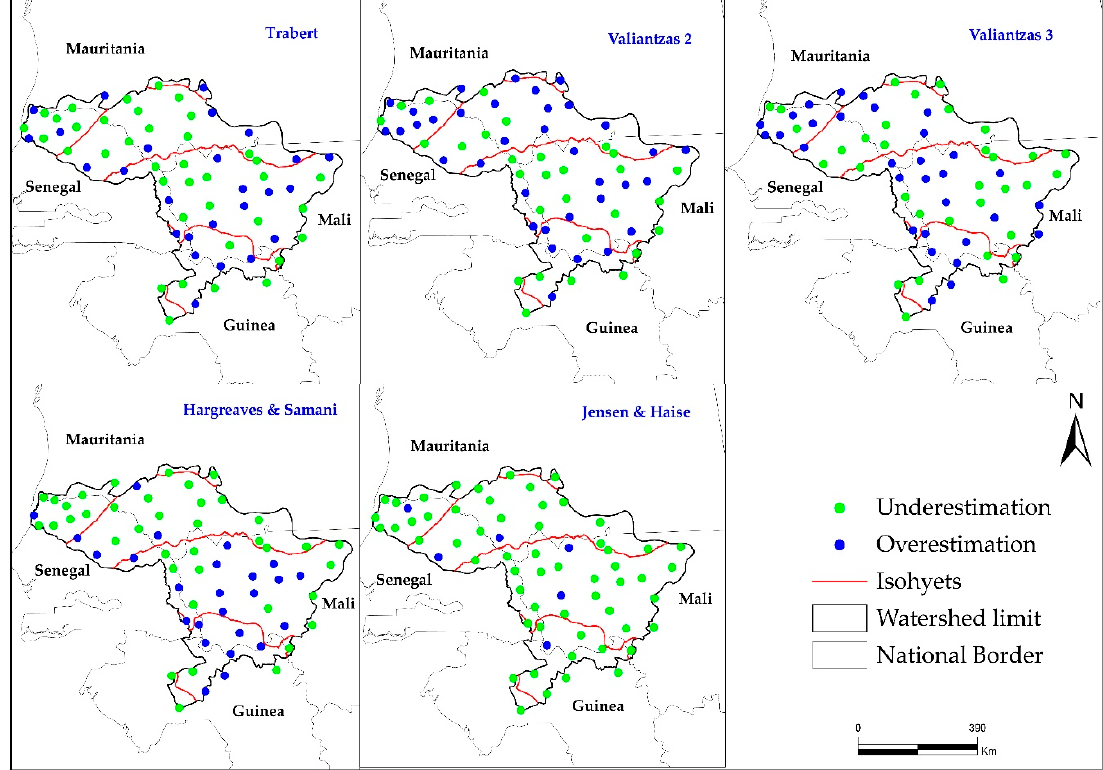
Figure 7. Spatial distribution of percentage of bias (PBIAS) between the best methods and that of FAO56-PM.